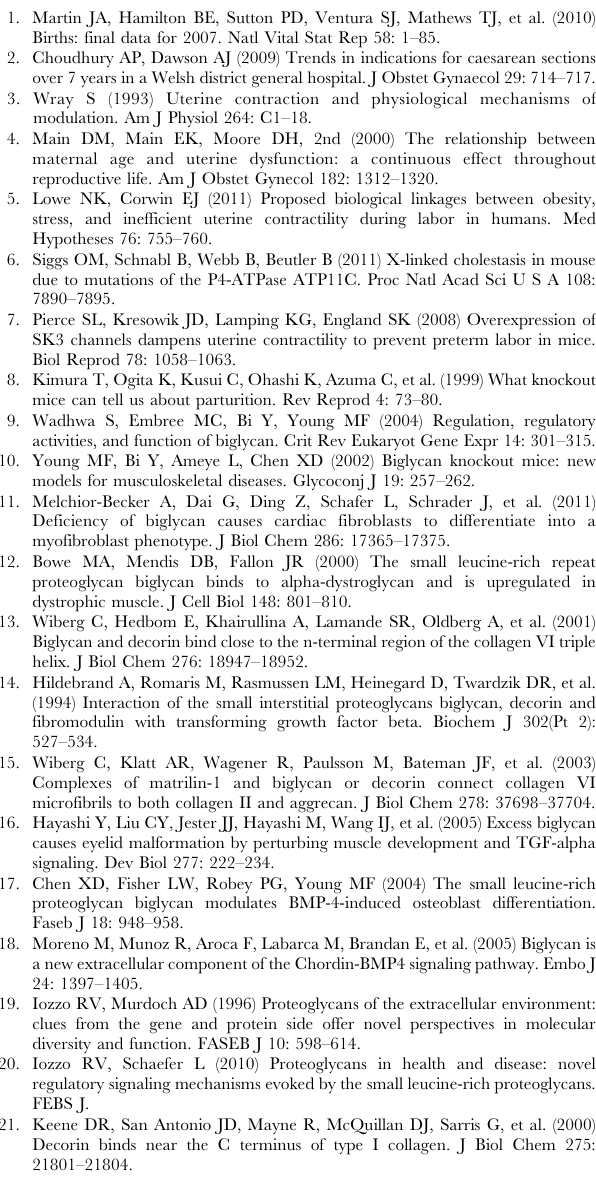
Figure S1 Biglycan and decorin localization in the mouse uterus. Immunohistochemical comparison of biglycan and decorin expression in the wild-type mouse uterine wall at E18. Both biglycan and decorin are localized to the myometrium and the endometrium to a similar degree. A slight increase in biglycan and decorin signal is noted around blood vessels (yellow arrows). 4 6 , scale bar 500 m m. The photomicrographs are representative of one uterus each from three pregnant females per experimental group. Table S1 Correlation of timing of birth and dystocia phenotypes per genotype. Dystocia is most likely